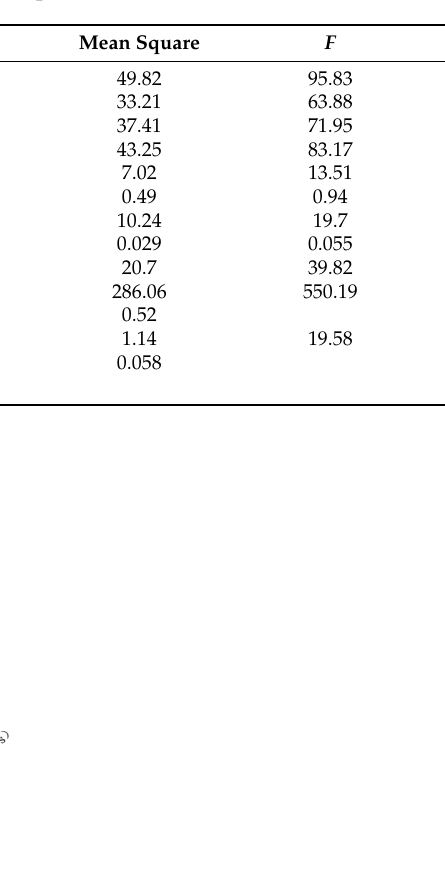
Table 5. Analysis of variance of regression equations.